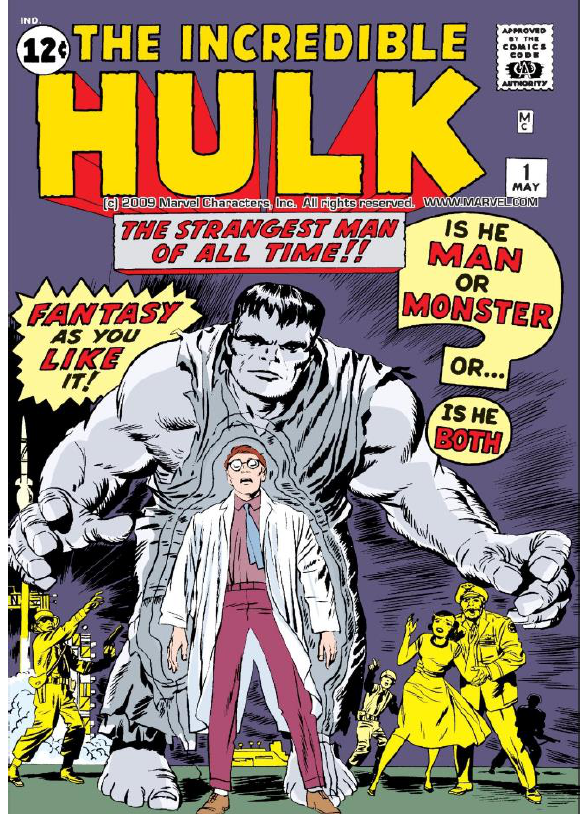
Figure 1. Cover art for Lee and Kirby’s The Incredible Hulk #1,